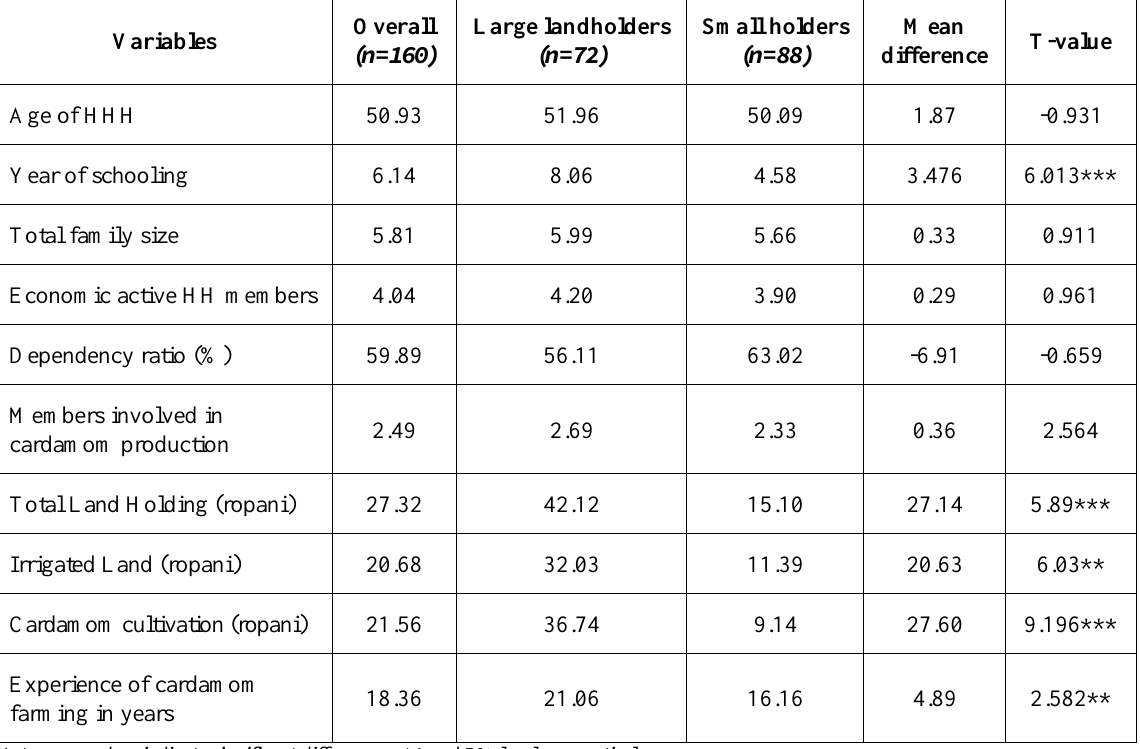
Table 1. Socio-demographic characteristics (continuous